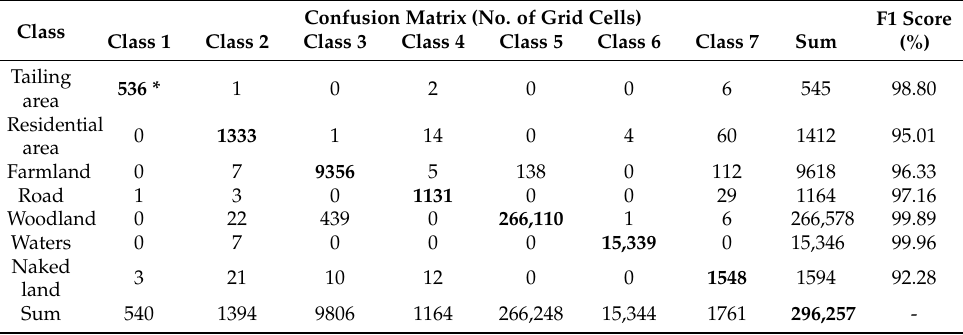
Figure 6. Determined classification factors for land cover mapping: ( a ) SARVI, ( b ) PC-1, ( c ) HSV_PCI, RGB color image from HSV space transformation (bands 4, 3, and 1), and ( d ) CF_TCI, RGB color image from convolution filtering (bands 3, 2, and 1). Table 4. Accuracy assessment of RF-based land cover classification